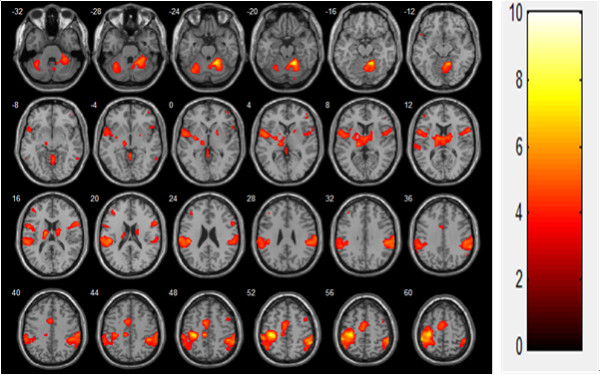
 FES combined voluntary contraction (N = 19, t(18) > 3.961, FDR < 0.05).